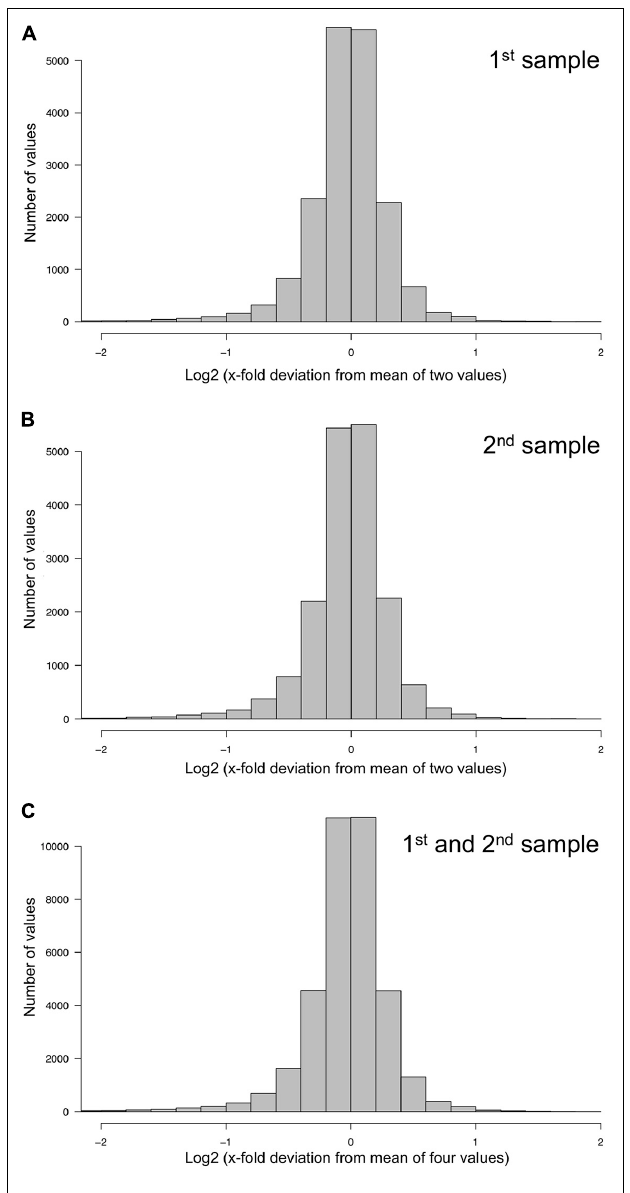
FIGURE 2 | Technical accuracy of measurements and homogeneity of gene expression within a plasmodial cell as determined by technical and biological replicates, taken in experiments #1 and #2 ( Table 2 ). (A,B) Technical accuracy of measurements of gene expression. The concentration of the mRNAs of the set of 35 genes ( Supplementary Table 2 ) was determined twice by RT-PCR for each RNA sample. The frequency distributions display the Log2 of the x-fold deviation of each expression value of each gene from the mean of the two values obtained by technical replication. Panels (A,B) show the results obtained for each of the two biological samples [ (A) , sample #1; (B) , sample #2], that both were simultaneously taken from the same plasmodial cell at any time point during the experiments. (C) Combination of the data sets shown in panels (A,B) . This frequency distribution shows the deviation of each measurement from the mean of four values, obtained by twice measuring each of the two biological samples simultaneously taken from the same plasmodium at any time point of the experiments. The figure represents the complete data set of 36,540 data points that was analyzed in the present